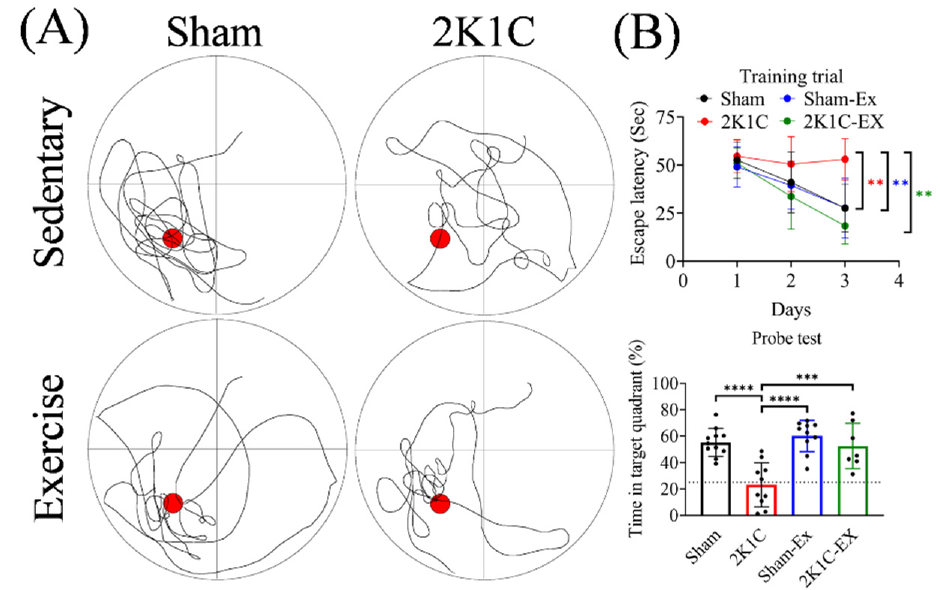
Figure 1. Exercise improved the 2K1C-hypertension-induced spatial memory impairment. ( A ) Maze schematic with swimming trajectory for different groups of mice. Red circle: removed escape platform. ( B ) Upper: Acquisition escape latency to find a hidden platform by day in the training trials. Lower: The time in target quadrant for hidden platform removed probe test. The averaged data and s.d. are plotted. The statistical analysis was performed by one-way ANOVA and Holm-Sidak’s multiple comparisons. The sample sizes for sham, 2K1C, Sham-Ex, and 2K1C-EX are 11, 10, 10, and seven, respectively. **: p < 0.01, ***: p < 0.001, ****: p < 0.0001.